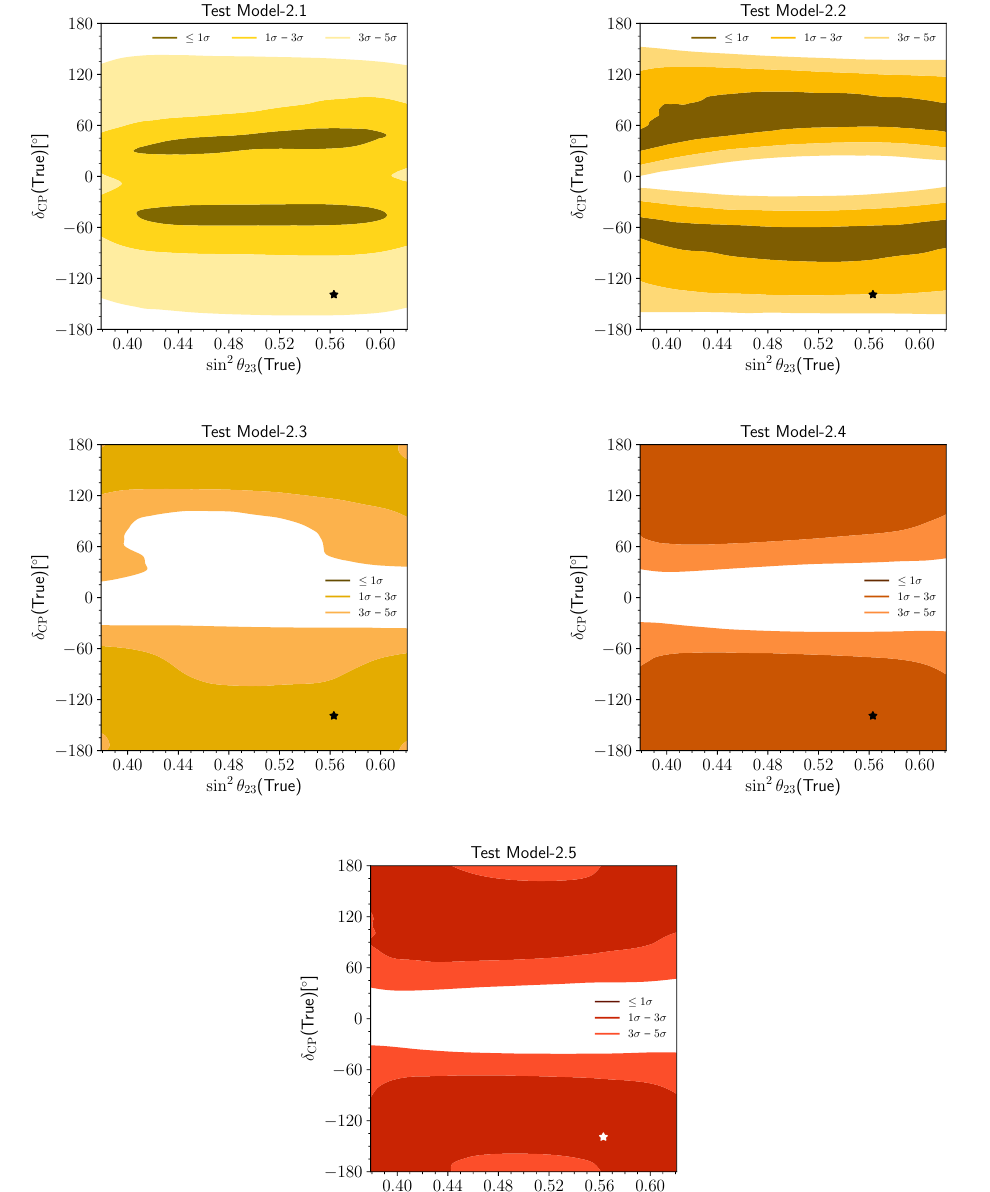
Figure 12 . Compatibility of the (cid:12)ve allowed two-parameter models with any potentially true values of sin 2 (cid:18) 23 and (cid:14) CP for ESSnuSB. For the other neutrino oscillation parameters, we assume 2 : 528 10 (cid:0) 3 eV 2 . A star (\ ? ") indicates the present best-(cid:12)t values of sin 2 (cid:18) 23 and (cid:14) CP from global (cid:1) neutrino oscillation data. The contours correspond to the indicated number of sigmas for 2 d.o.f.